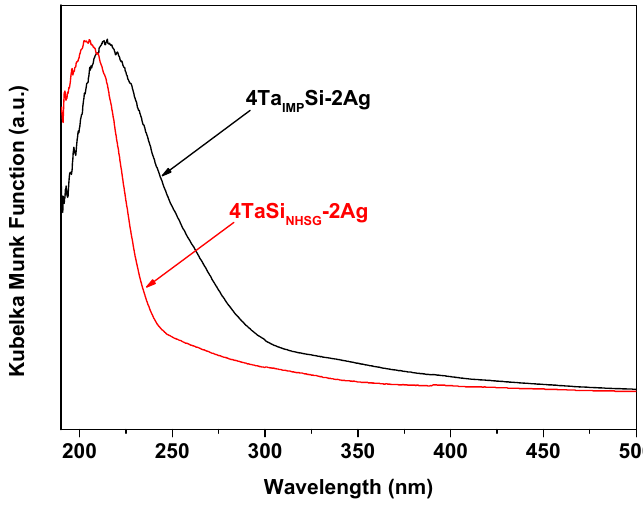
Figure 4. DRUV spectra obtained for 4TaSi NHSG -2Ag and 4Ta IMP Si-2Ag.